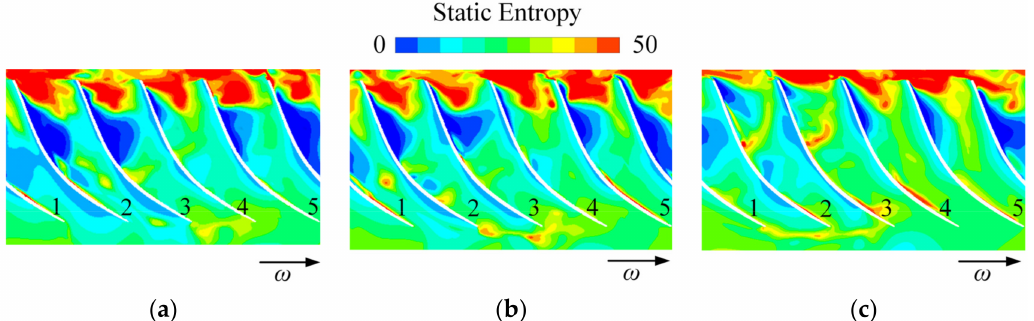
Figure 11. Contours of instantaneous static entropy in the impeller passages (97% span, IGV30, ϕ = 0.0833): ( a ) t 1 = 0.11135 s; ( b ) t 2 = 0.11338 s; ( c ) t 3 = 0.11734